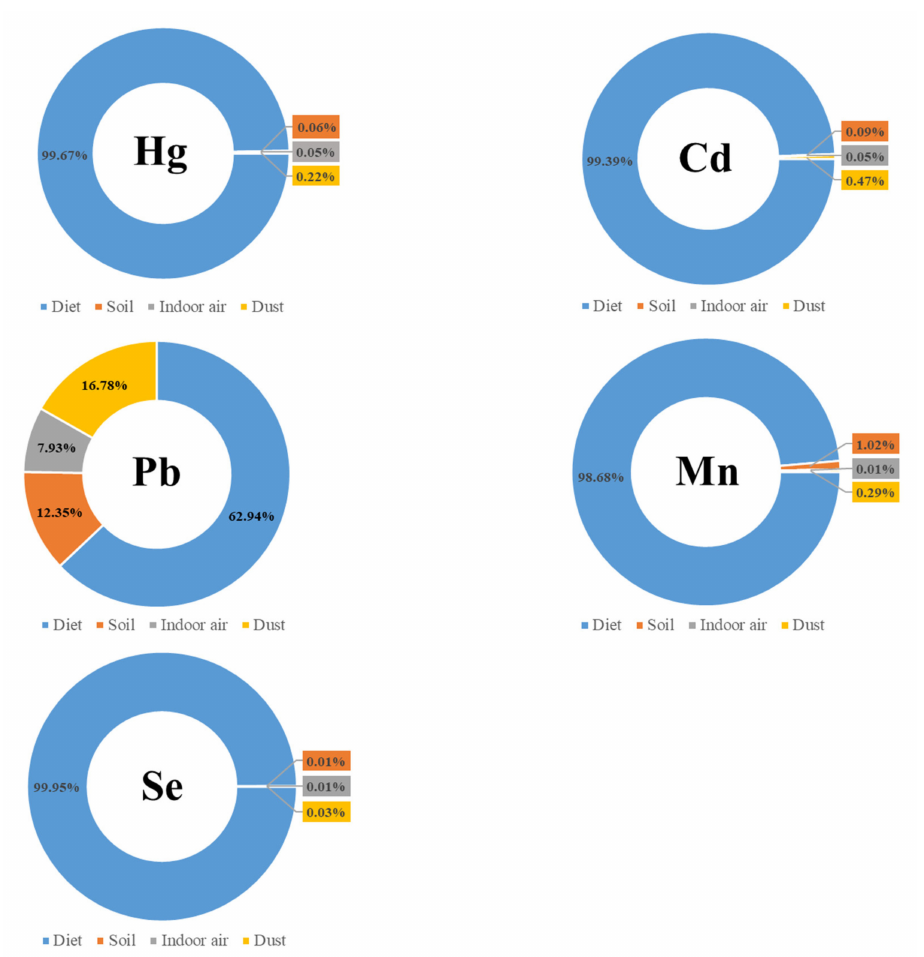
Figure 2. Contribution of each exposure route to Hg, Cd, Pb, Mn, and Se